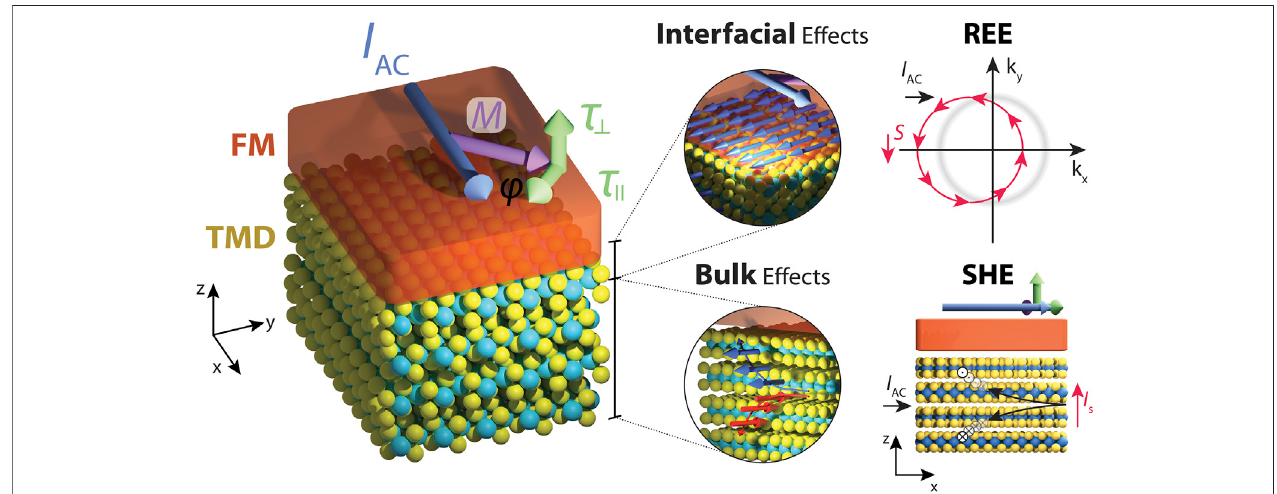
FIGURE 1 | Schematics of SOTs in TMD/FM heterostructures. A charge current, usually oscillating at low (RF) frequencies for SHH (ST-FMR) measurements is appliedalongadeviceconsistingofaTMDlayerandaFM.ThemagnetizationoftheFMlayer,orientedalonganexternalmagnetic fi eld,observesacurrent-inducedSOT in-plane ( τ (cid:3) ) and out-of-plane ( τ ⊥ ), indicated by the green arrows. These torques may arise from multiple microscopic effects arising in the bilayer, which may originate eitherfromtheTMD/FMinterface(top),e.g.,throughtheRashba-EdelsteinEffect(REE),orthebulkofthematerial(bottom),asforexamplethroughaspinHalleffect (SHE) in the TMD